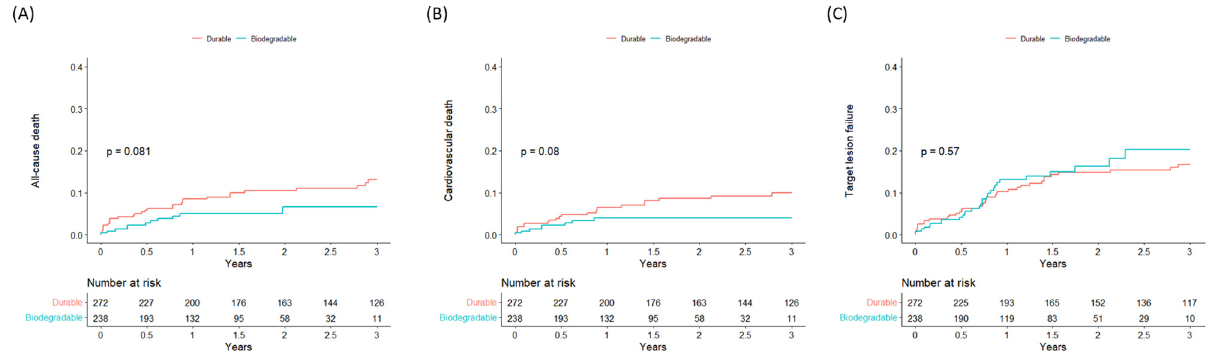
Figure 2. Kaplan–Meier curves of clinical outcomes according to polymer durability. ( A ) all-cause death, ( B ) cardiovascular death, ( C ) target-lesion failure. Table 2. Clinical endpoints before and after adjustment using propensity score matching.